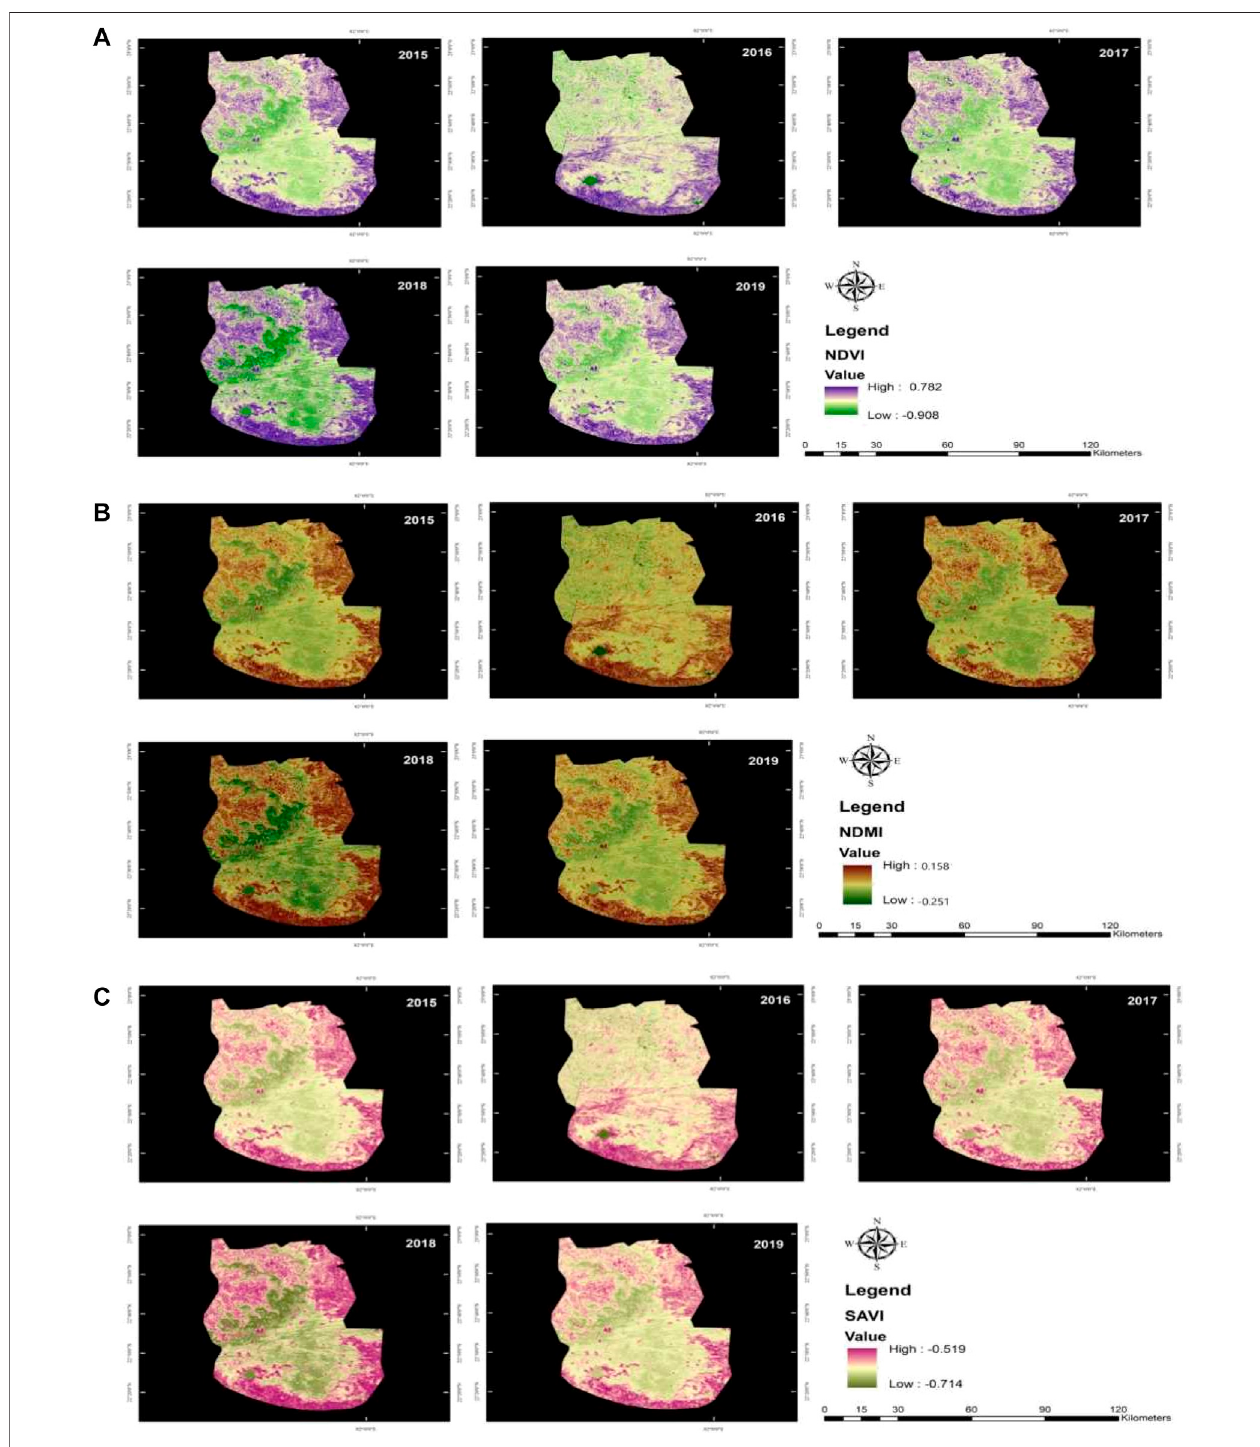
FIGURE 7 | Spectral vegetation indices (NDVI, NDMI, and SAVI) of AABR